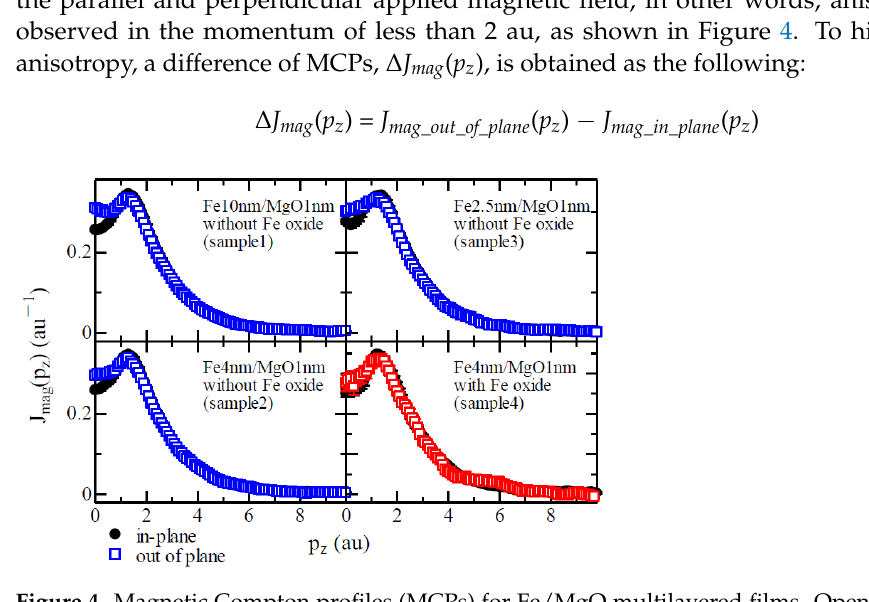
Figure 5. Anisotropies of Magnetic Compton profiles for Fe/MgO multilayered films obtained from Figure 4. Solid lines denote the fitting results explained later. To analyze the anisotropy of the MCPs, we calculate the model MCPs for the mag- netic quantum numbers, | m | = 0, 1 and 2 states, assuming the atomic wavefunction of Fe 3 d under a uniaxial crystal field, whose quantization axis is perpendicular to the film plane. Figure 6 shows the model calculation of MCPs in the applied magnetic field (a) parallel (in-plane) and (b) perpendicular (out-of-plane) to the film plane for the magnetic quantum numbers, | m | = 0, 1 and 2 states. The anisotropies Δ J mag ( p z )s are also obtained by using Equation (1), as shown in Figure 6c. The anisotropies depend on the magnetic quan- tum numbers, | m | = 0, 1 and 2 states. Therefore, the anisotropies in Figure 5 can be de- composed into each contribution of the magnetic quantum number by fitting the analysis with the basis functions shown in Figure 6c. The fitting results are shown in Figure 5. The experimental anisotropies can be fitted well by the model calculation in Figure 6c, as shown in Figure 5.